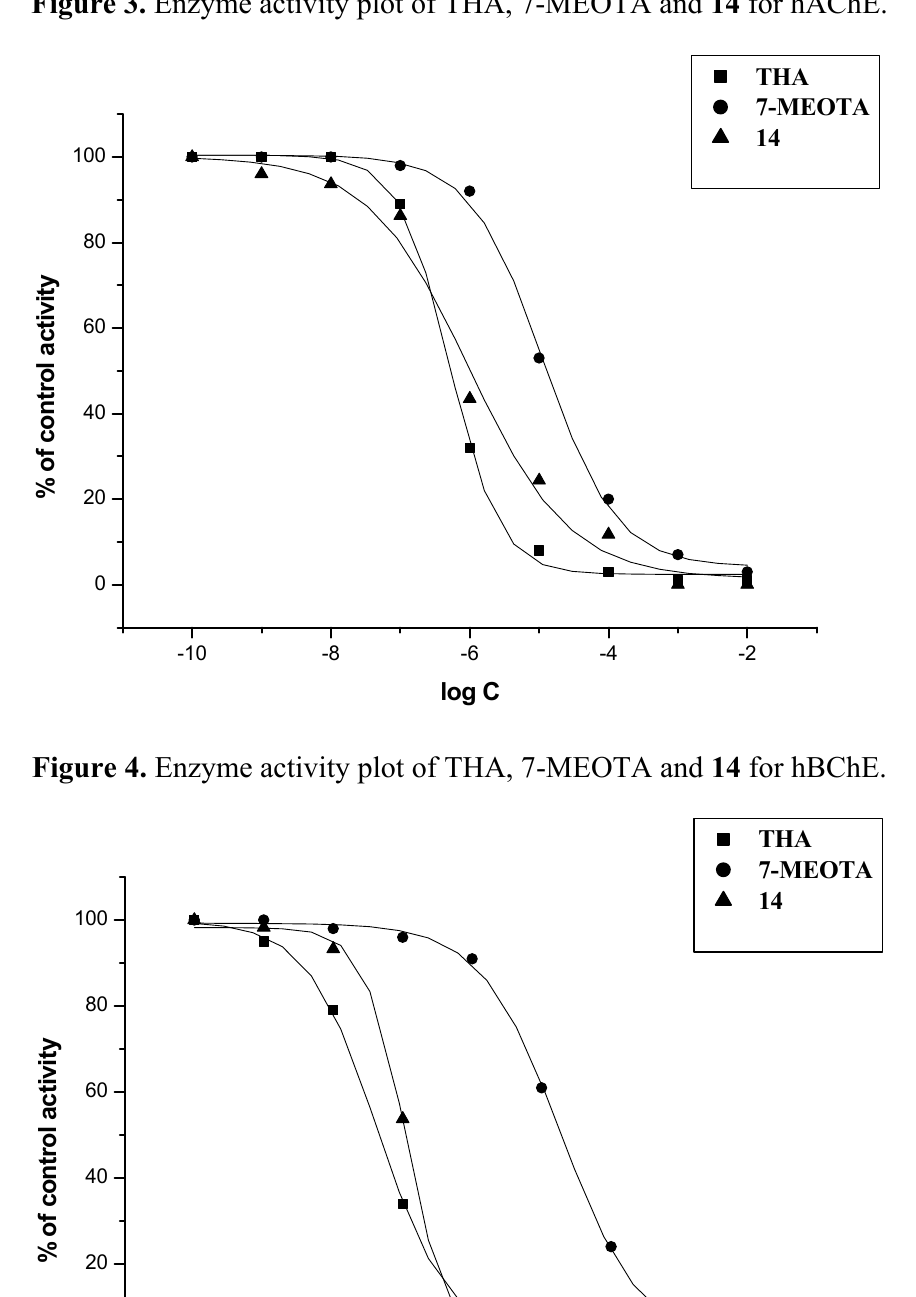
Figure 3. Enzyme activity plot of THA, 7-MEOTA and 14 for hAChE.